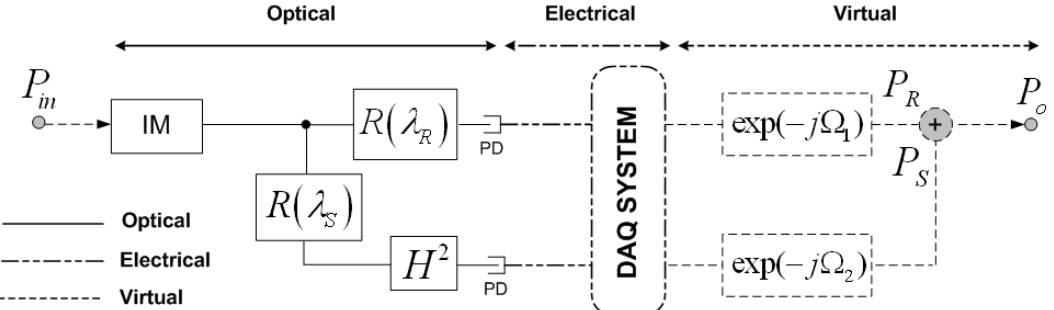
Figure 1. Filter model of the proposed topology for a generic remote sensing point with two virtual delay lines, after acquisition, at the reception stage. IM: Intensity Modulator, PD: